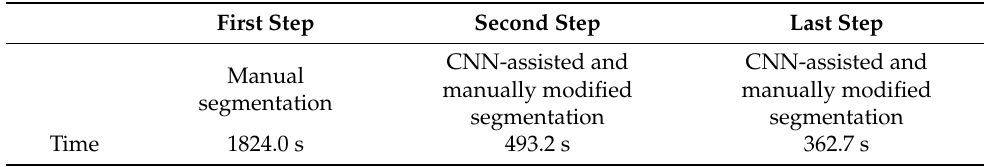
Figure 4. Best (first rows) and worst (second rows) from the test dataset on internal-KUAH and external-KUANH. Comparisons of the maxillary sinus segmentation times between CNN-assisted and manual segmentation are given in Table 4. The time consumed by the CNN-assisted and manually modified segmentation decreased by approximately 493.2 s for 30 scans in the second step, and by approximately 362.7 s for 76 scans in the last step when compared to that taken in the first step. Table 4. Comparison of segmentation times between the manual and CNN-assisted and manually modified segmentation